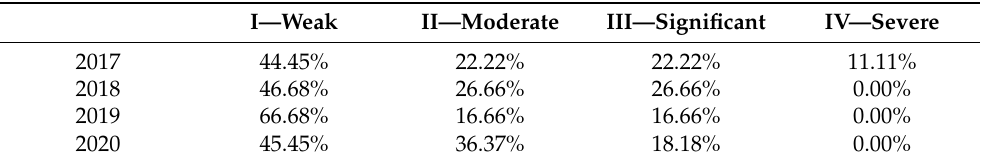
Table 3. Distribution of the sea storm events in the years 2017–2020 according to the energy classi- fication. I—Weak